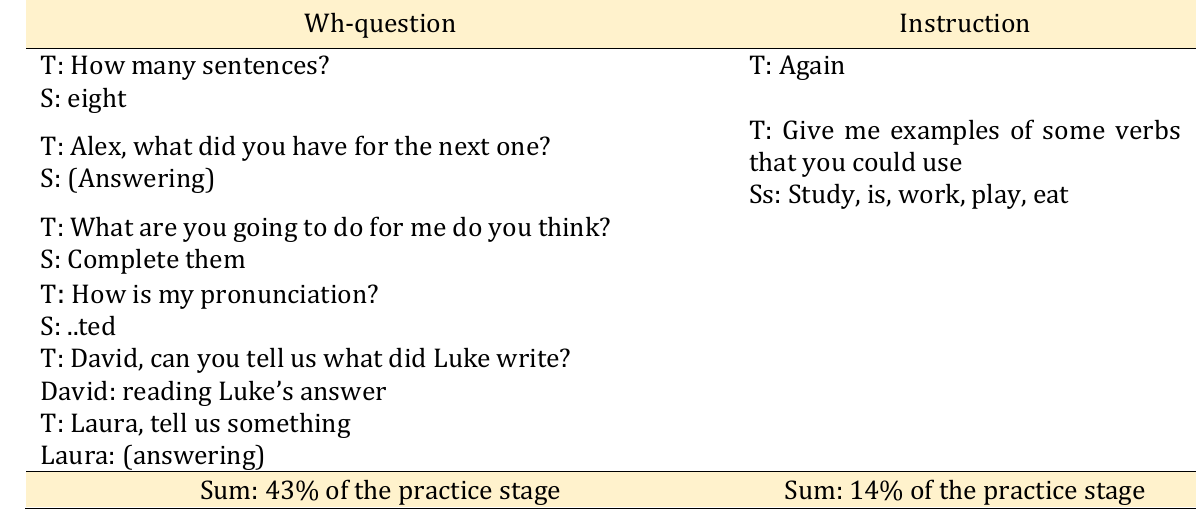
Table 3. Open-ended questions in the practice stage